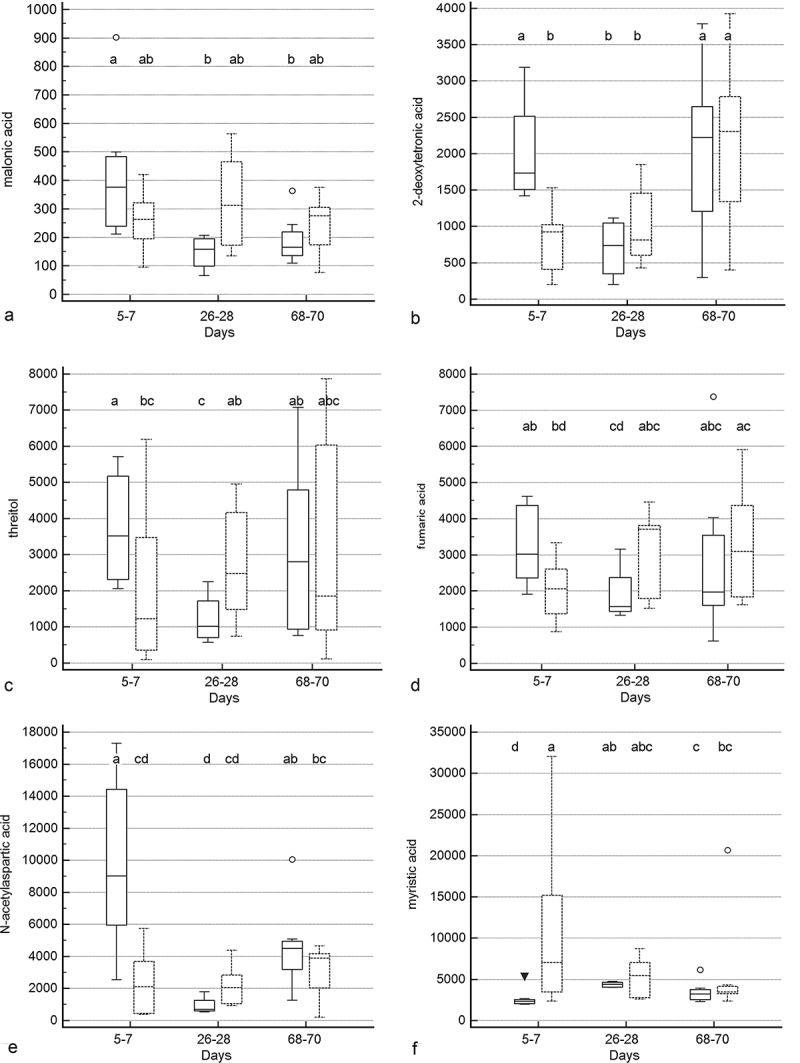
Box and whisker plots of fecal metabolite profiles for selected fecal metabolites that differed significantly (fdr - adjusted P < 0.05) between treatment groups and over time. Figure 5a:(A) Malonic acid. (B) 2-deoxytetronic acid. (C) Threitol. (D) Fumaric acid. (E) N-acetylaspartic acid. (F) Myristic acid. Figure 5b: (A) 5,6-dihydrouracil major. (B) Malic acid. (C) Octadecanol. (D) Palmitoleic acid. Figure 5c: (A) Myo-inositol. (B) 2-hydroxybutanoic acid. (C) Squalene. (D) Dihydrocholesterol. Medians, interquartile ranges, and minimum and maximum values are presented for cats in the placebo (boxes with solid borders) and synbiotic (boxes with dashed borders) treatment groups. Open circles and closed triangles denote outlier values. Fecal samples were collected at baseline (days 5–7), at the conclusion of antibiotic administration (days 26–28), and after a 6-week washout (days 68–70) from 16 healthy cats, 8 per group,+ that received 150 mg clindamycin with either a placebo or synbiotic PO once daily for 21 days. +Feces from four cats (placebo group) were unavailable at time point 26–28 because of early termination of treatment due to severe gastrointestinal signs. Significance was set as P < 0.05, with P-values adjusted based on the Benjamini and Hochberg False discovery rate (fdr). Boxes that do not share a letter differed significantly (fdr-adjusted P < 0.05) based on post hoc analysis. For squalene, post hoc analysis did not clarify the group association. Both treatment group and group by time interactions were identified for dihydrocholesterol.